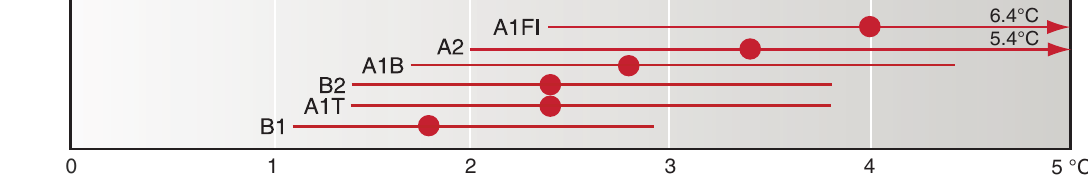
Figure SPM.7. Examples of impacts associated with projected global average surface warming. Upper panel: Illustrative examples of global impacts projected for climate changes (and sea level and atmospheric CO where relevant) associated with different amounts of increase in 2 global average surface temperature in the 21 st century. The black lines link impacts; broken-line arrows indicate impacts continuing with increas- ing temperature. Entries are placed so that the left-hand side of text indicates the approximate level of warming that is associated with the onset of a given impact. Quantitative entries for water scarcity and flooding represent the additional impacts of climate change relative to the conditions projected across the range of SRES scenarios A1FI, A2, B1 and B2. Adaptation to climate change is not included in these estimations. Confi- dence levels for all statements are high. Lower panel: Dots and bars indicate the best estimate and likely ranges of warming assessed for the six SRES marker scenarios for 2090-2099 relative to 1980-1999. {Figure 3.6}